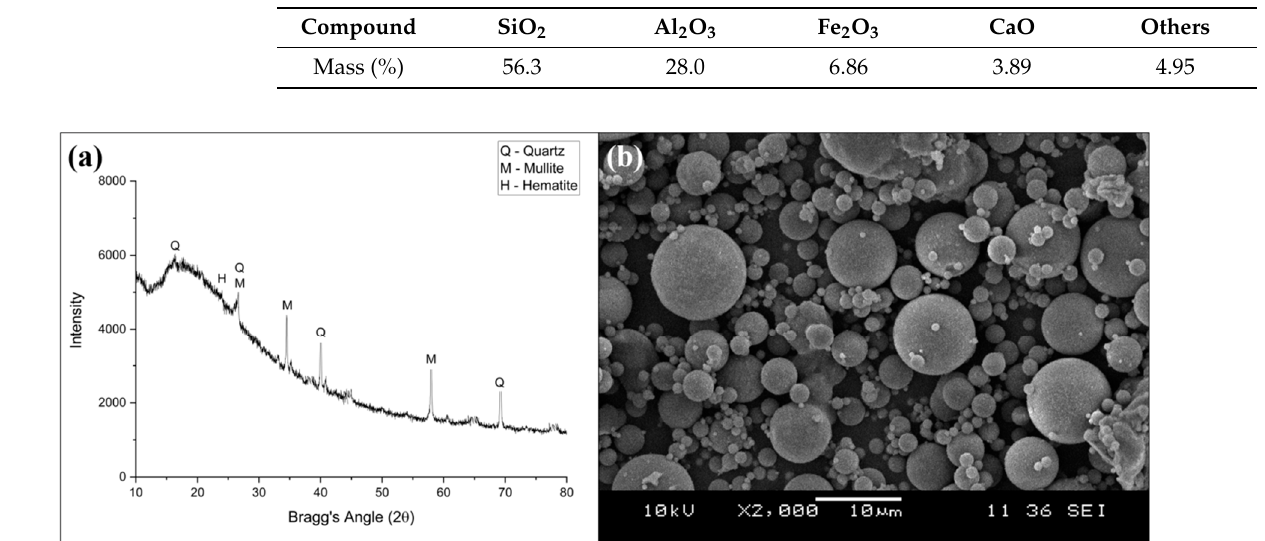
Figure 1. ( a ) XRD diffractogram and ( b ) Scanning electron microscope (SEM) micrograph of Class F fly ash.